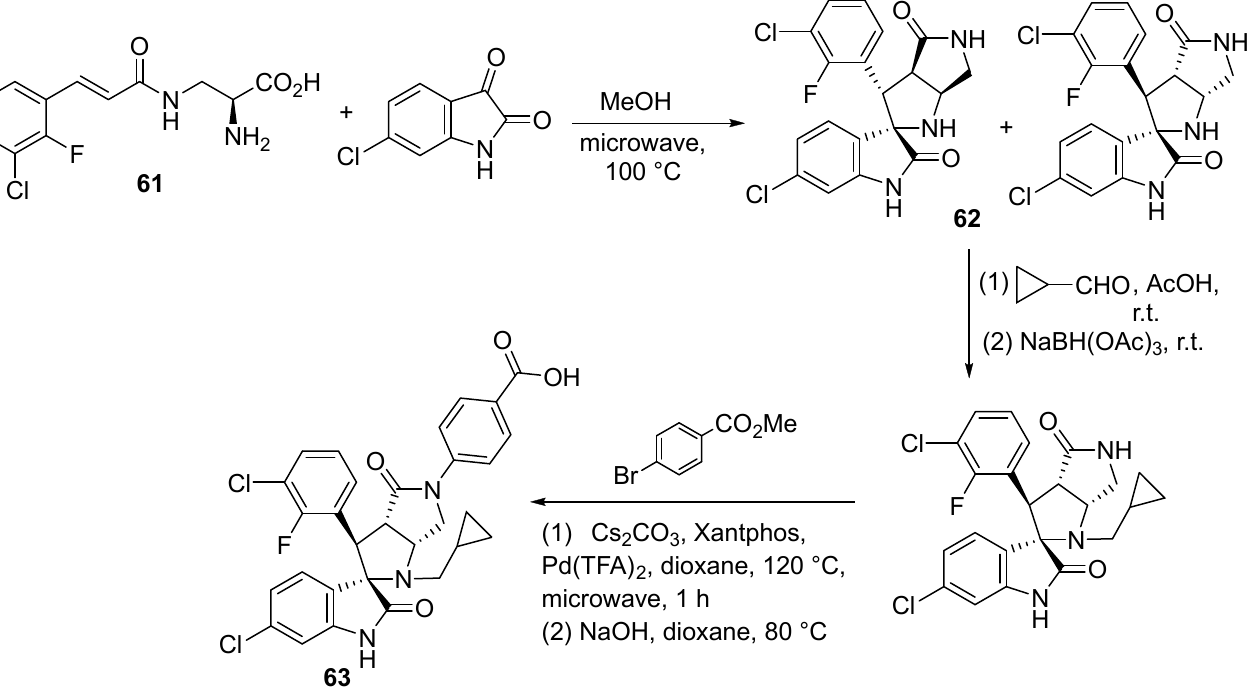
Scheme 15. Synthesis of spirooxindole derivative 63 .